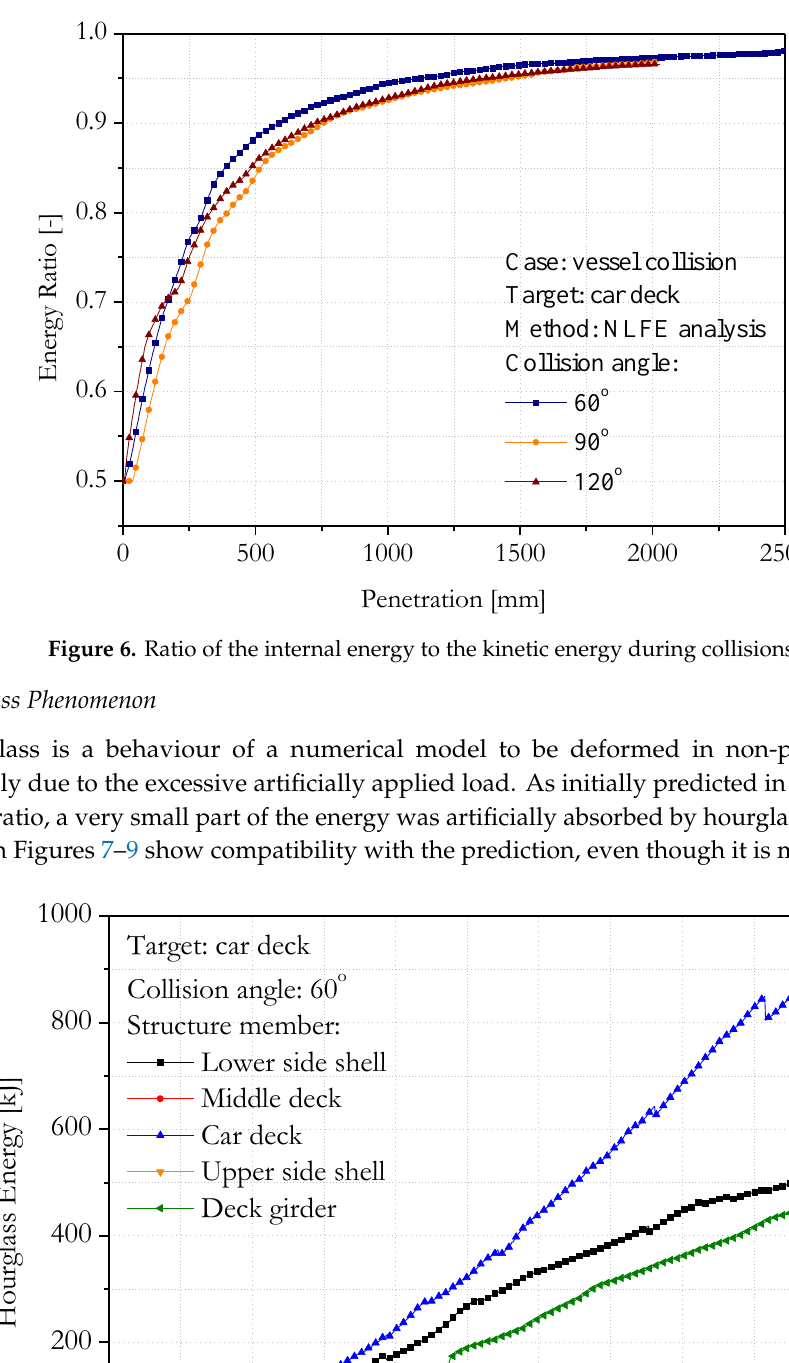
Figure 7. Hourglass energy of the collision angle 60°.